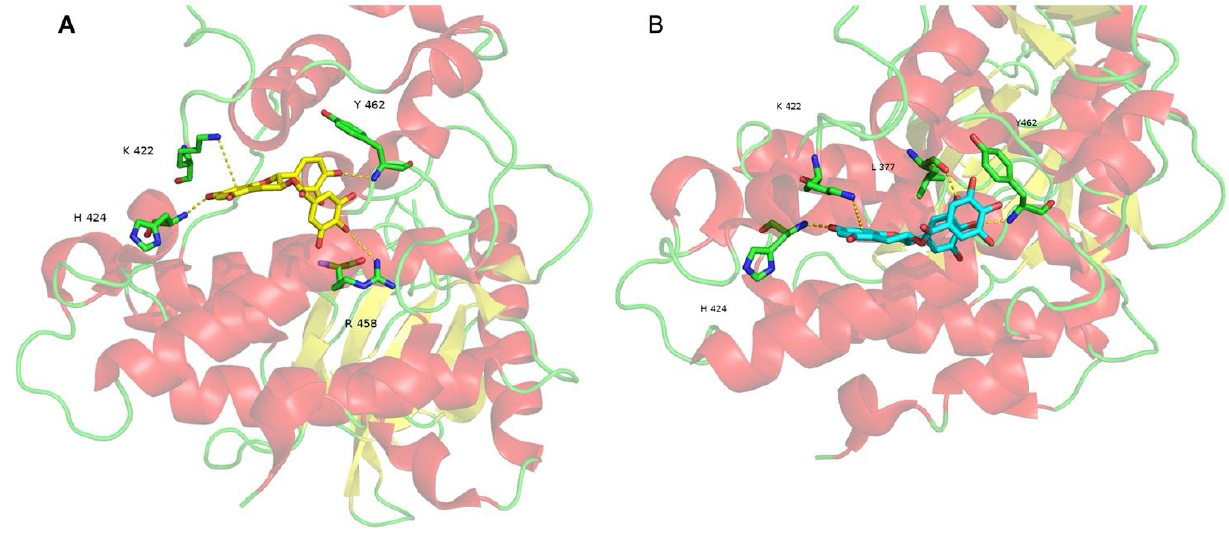
Figure 3. The docking results for ( A ) CG and ( B ) GCG. DYRK1A is in cartoon representation. CG, GCG and the residues forming non-covalent bonds are in sticks representation.